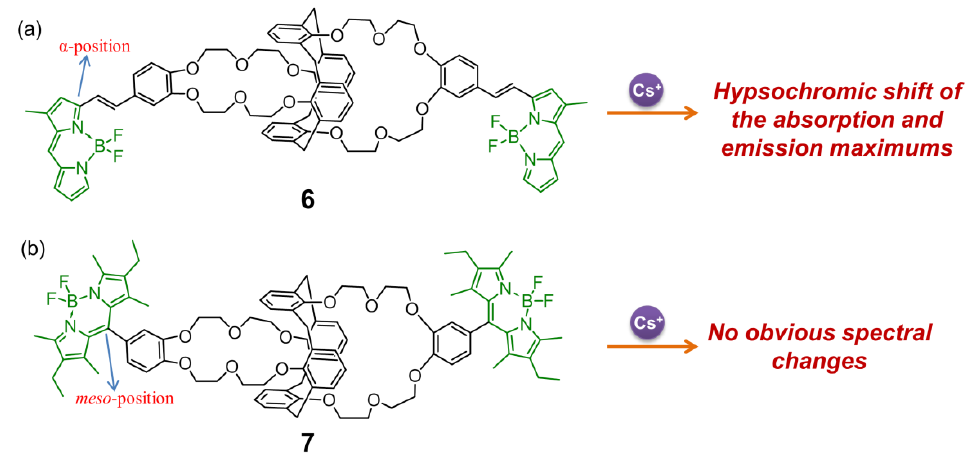
Figure 6. Structures of calix[4]arene-based probes ( a ) 6 and ( b ) 7 .